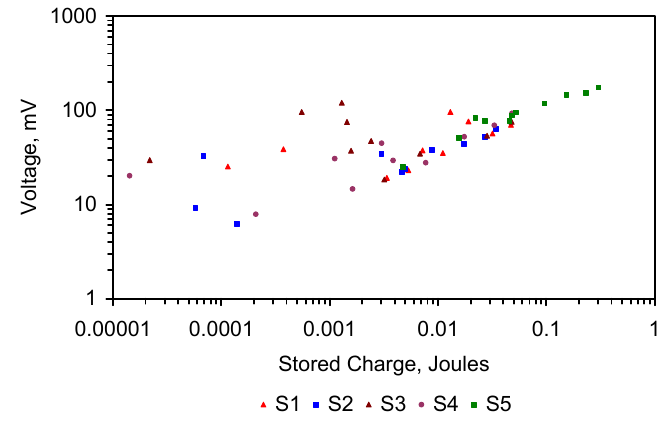
Figure 14. Relationship between measured voltage and stored charge associated with ZVM